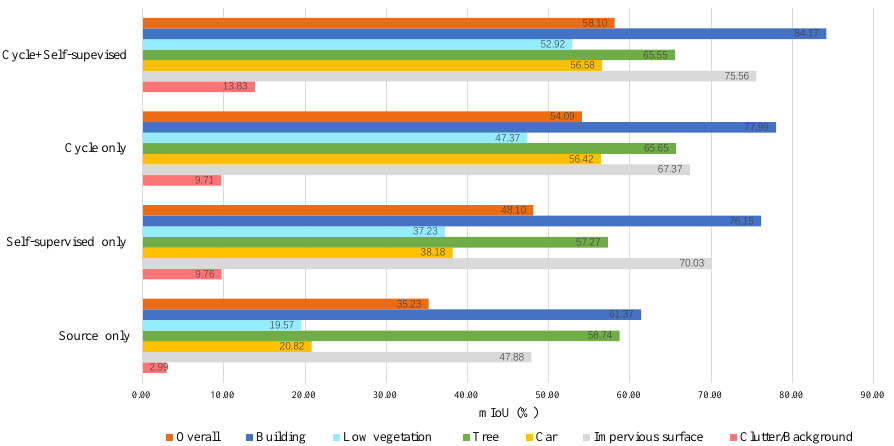
Figure 10. Ablation study of contribution of each component to accuracy of individual classes on Potsdam IRRG → Vaihingen